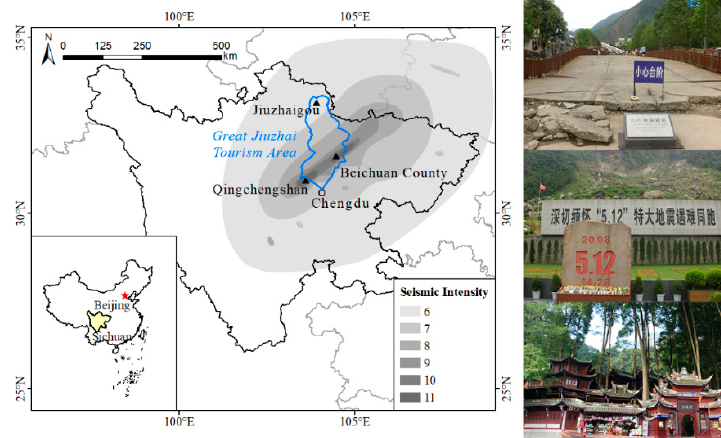
Figure 2. Study area, seismic intensity and panorama.